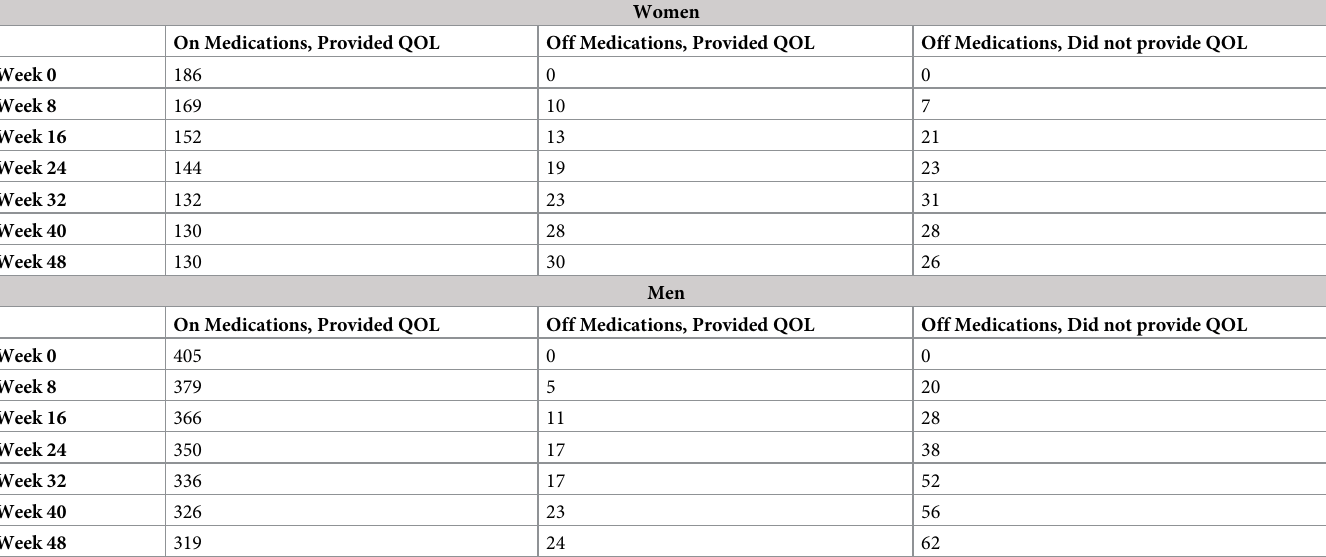
Table 2. Number of participants that discontinued regimens or missed quality of life